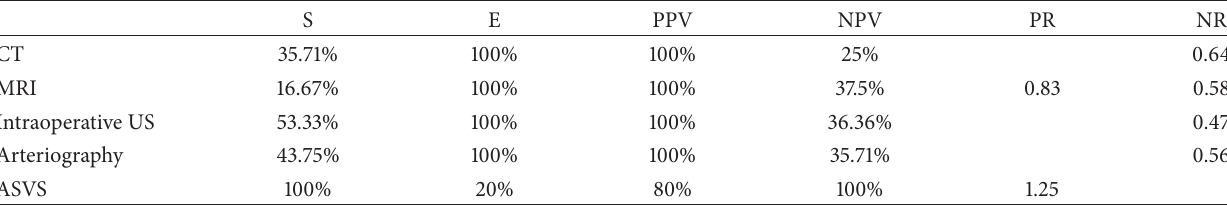
Table 2: Indices for evaluating diagnostic tests for the detection of